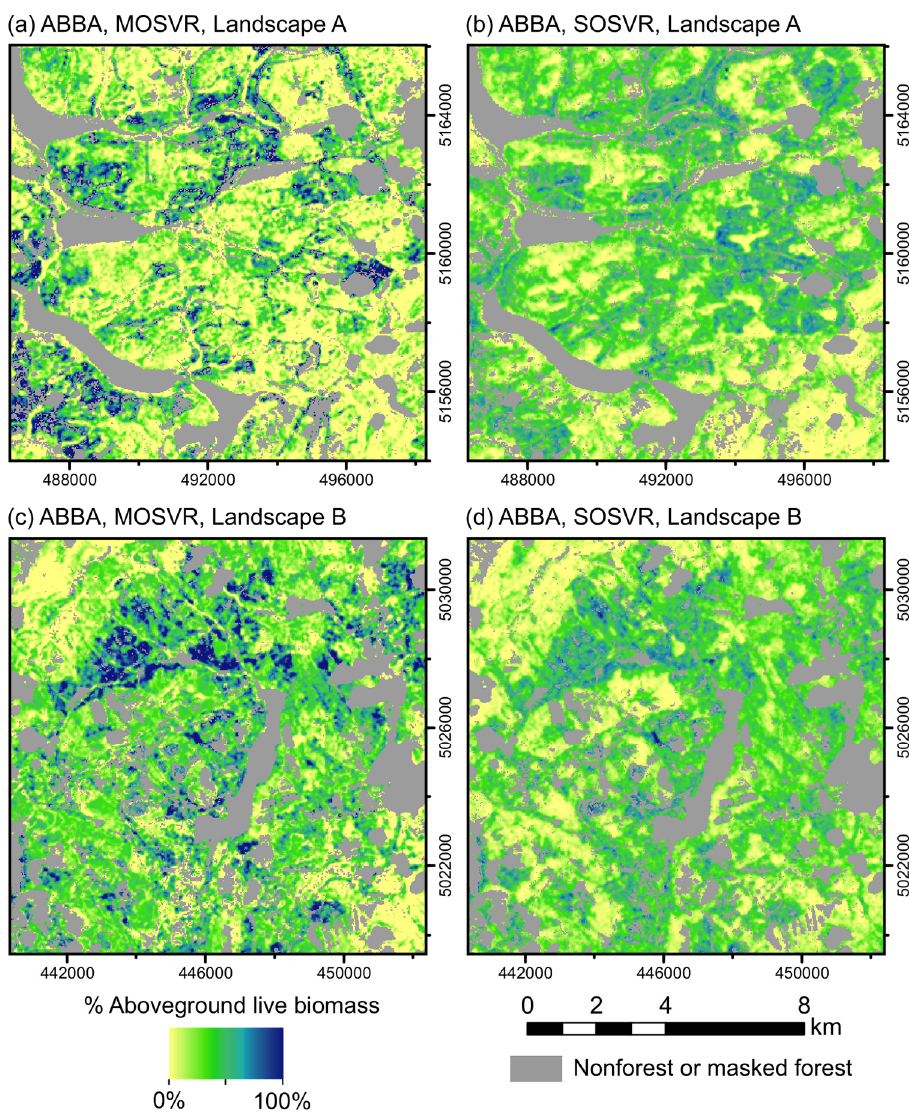
Figure 9. Spatial predictions of relative abundance for species ABBA (balsam fir). Relative abundance predicted from ( a , c ) MOSVR and ( b , d ) SOSVR models, across two randomly positioned sample landscapes 12 km x 12 km in size (UTM zone 19N, WGS84). Masked areas include non-forest pixels, forest pixels a ff ected by canopy change during the study period, or missing data due to cloud or snow cover. Predictions were truncated at 0 and